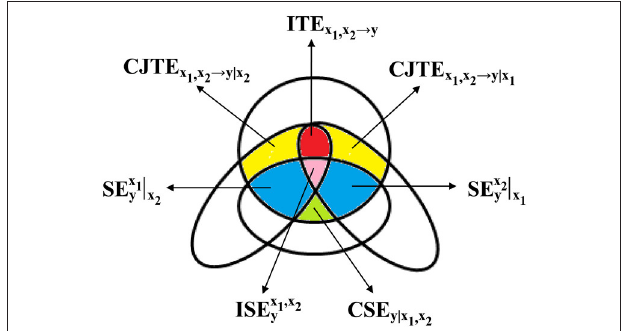
FIGURE 1 | A mnemonic Venn diagram, redrawn from Porta et al. (2015), of the information-theoretic quantities contributing to the decomposition of PE y in (cid:127) = { y,x 1 , x 2 }. The diagram is devised to represent in the information domain the terms whose sum gives the JTE x 1 , x 2 → y according to Equation (21), i.e., CJTE x CJTE